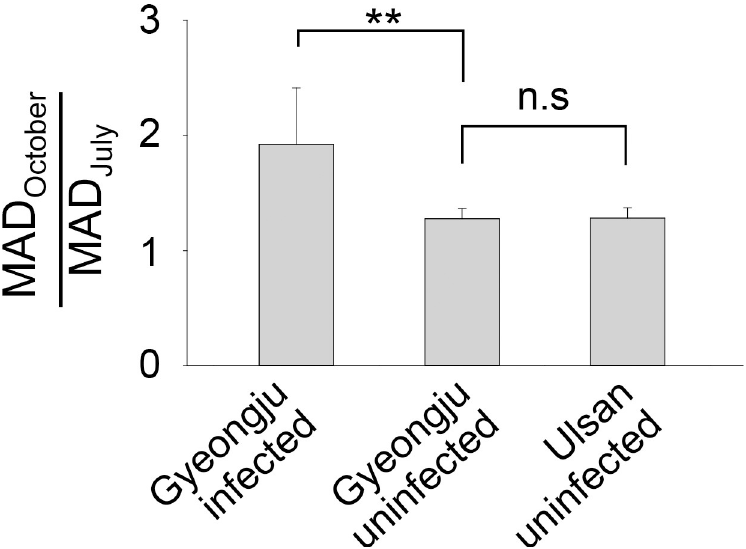
Fig 6. Difference in the ratio of MAD October and MAD July between infected and uninfected trees. Sample size: n = 13 for Gyeongju infected; n = 50 for Gyeongju uninfected; n = 45 for Ulsan uninfected. �� p < 0.01; p -value, one- way ANOVA on ranks. n.s: Not significant. The bars and error bars stand for means and 95% confidence intervals, respectively.